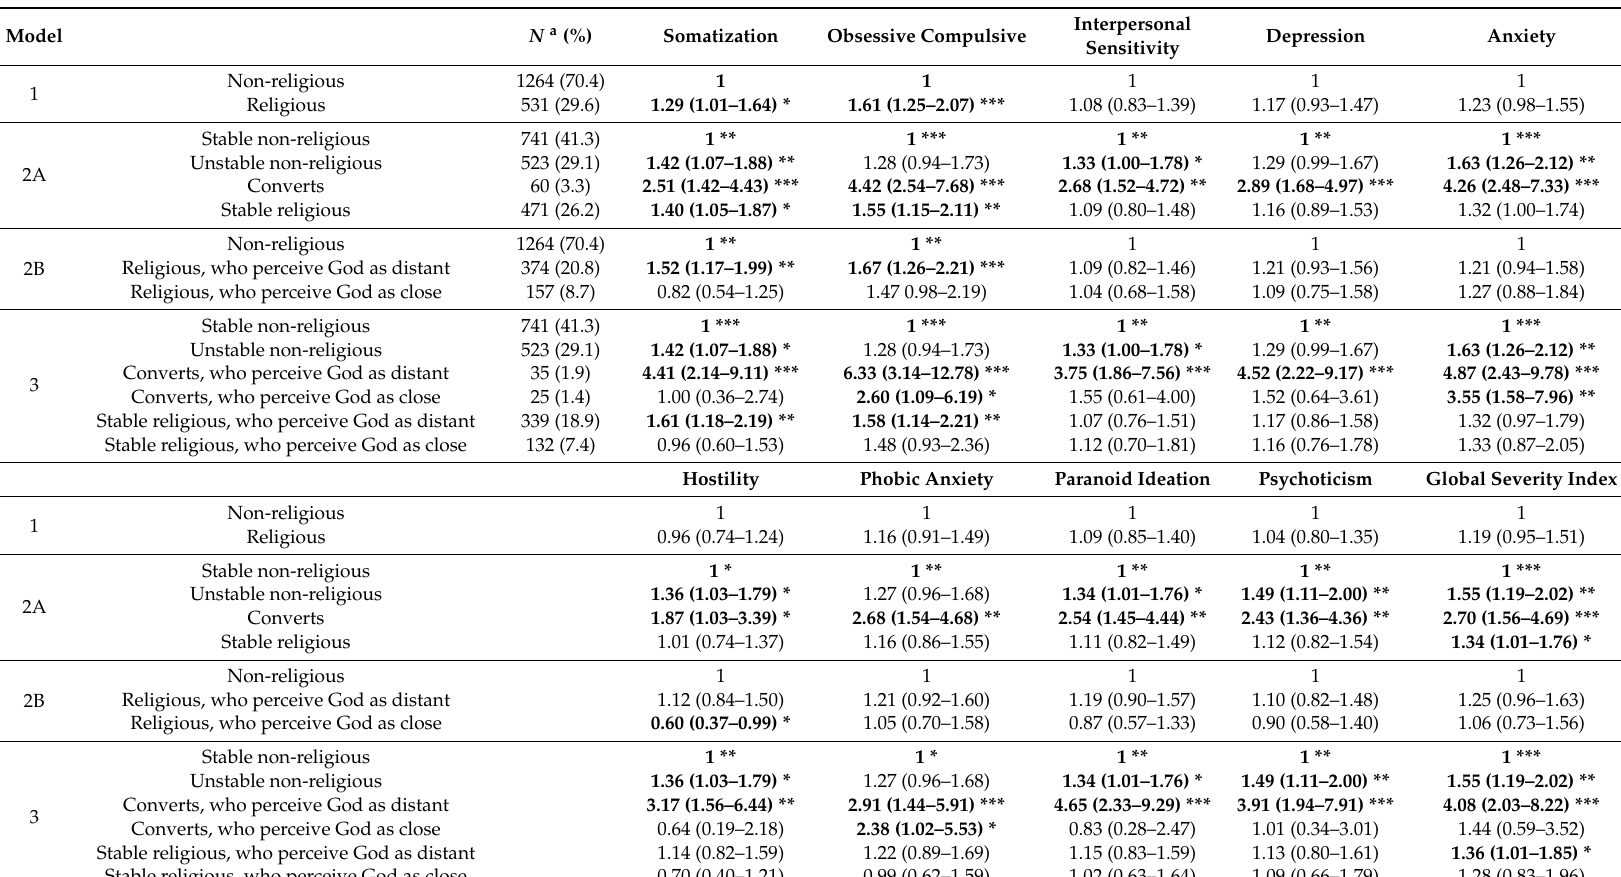
Table 3. Associations of di ff erent R / S models with selected Brief Symptom Inventory (BSI) symptoms and the Global Severity Index (GSI): results of binary logistic regression with the stable non-religious respondents being the reference category, adjusted for age, gender and education level leading to odds ratios (OR) with 95% confidence intervals (95%